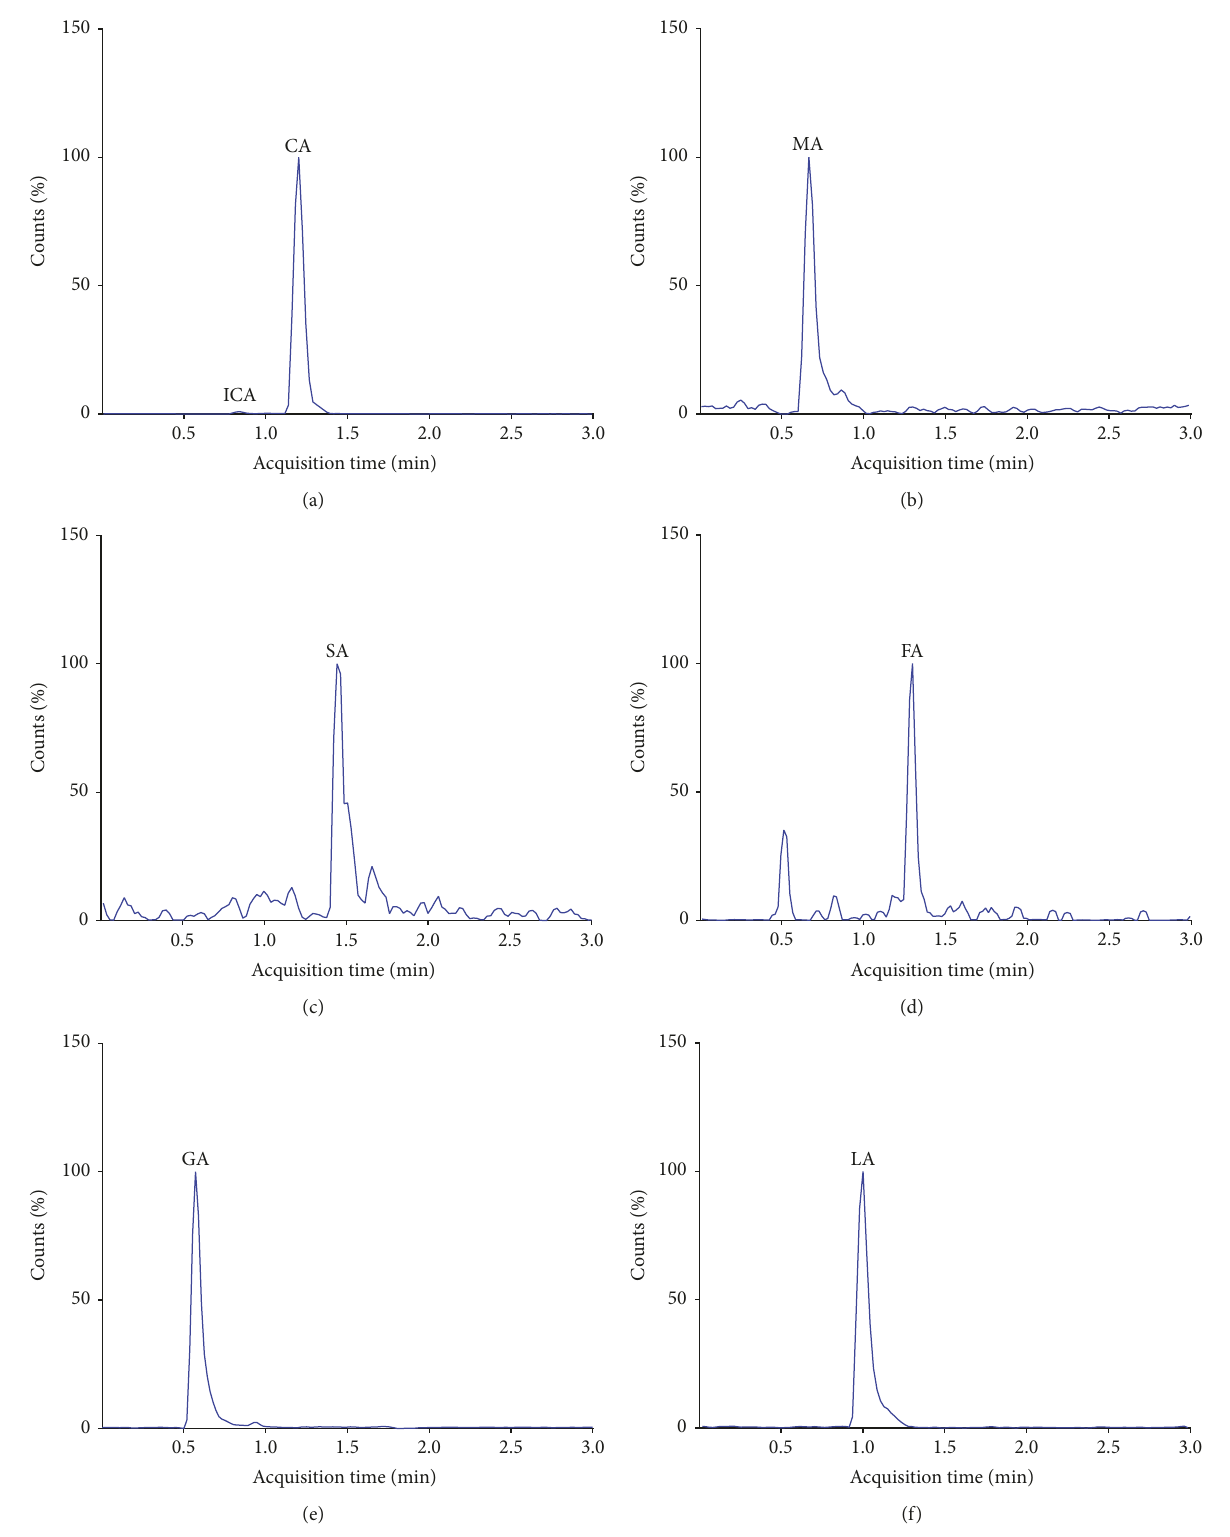
Figure 2: LC-MS/MS chromatograms of TCA cycle intermediates in human plasma. (a) Citric (CA) and isocitric (ICA) acids; (b) malic acid (MA); (c) succinic acid (SA); (d) fumaric acid (FA); (e) glutamic acid (GA); (f) lactic acid